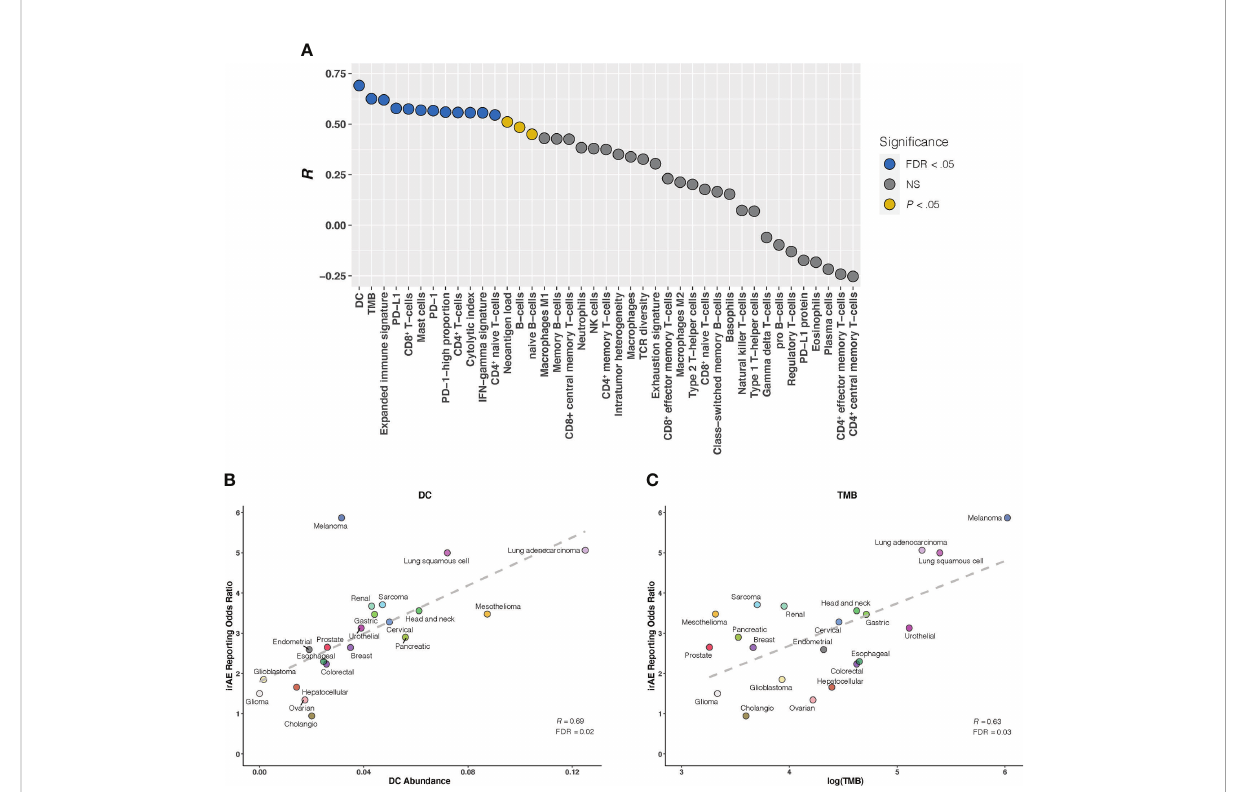
FIGURE 1 Correlation Between Established Immunogenomic Factors and Immune-Related Adverse Events for Anti – PD-1 Therapy Across Cancer Types (A) , Evaluation of immunogenomic correlates of immune-related adverse events (irAEs) for immunotherapy to block the PD-1 pathway across cancer types. The horizontal axis denotes the 41 established immunogenomic factors, and the vertical axis denotes Pearson correlation coef fi cient ( R ). Circles are fi lled with distinct colors as per statistical signi fi cance of corresponding factors. (B, C) , Correlation of dendritic cells abundance (DC) (B) and log(tumor mutational burden [TMB]) (C) with the reporting odds ratio of any irAE across 21 cancer types which are color coded. The dashed line depicts the linear fi t. FDR, false discovery rate; NS, not signi fi